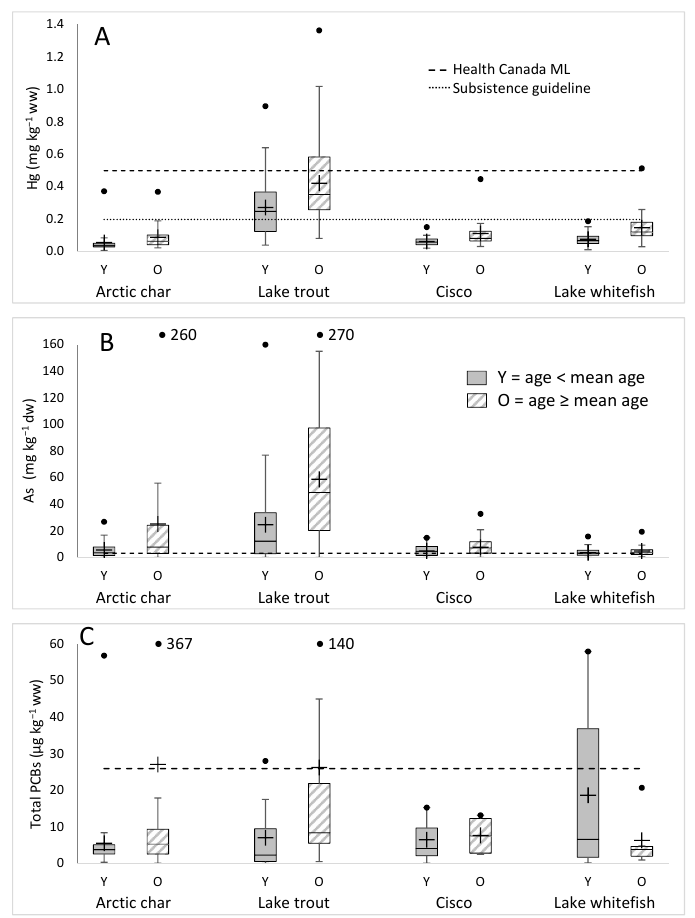
Figure 2: Box plots of A. Hg (µg kg -1 ww), B. As (mg kg -1 dw), and C. total PCB (µg kg -1 ww) Figure 2. Box plots of contaminants assayed in di ff erent fish and grouped as either young (Y) concentrations grouped by fish species. Black points are maximum values and crosses are means. Off- scale maximum values are provided in text boxes. Dotted lines are guidelines. or older (O) fish, defined as those younger than the mean age or at the mean age or older, respectively. ( A ). Hg ( µ g · kg − 1 ww), ( B ). As (mg · kg − 1 dw), and ( C ). total polychlorinated biphenyls (PCB) ( µ g · kg − 1 ww) concentrations with black points representing maximum values and crosses indicating means. O ff -scale maximum values are provided in text boxes. Dotted horizontal lines are guidelines or advisories. See the Discussion for Health Canada maximum level (ML) or regulatory unit guidelines and other advisory